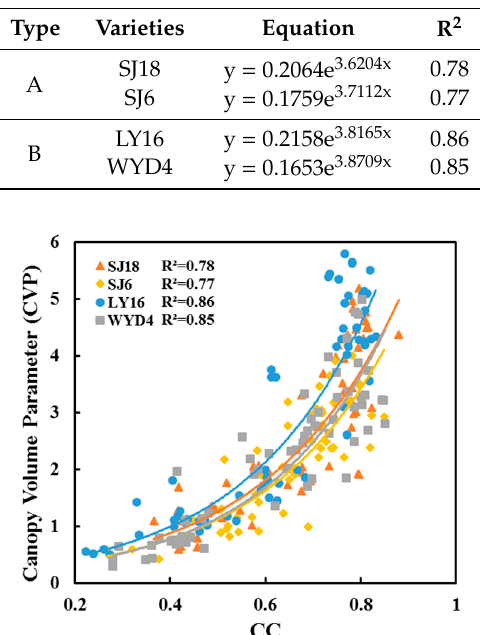
Figure 5. Relationships between the canopy cover (CC) and canopy volume parameter (CVP).